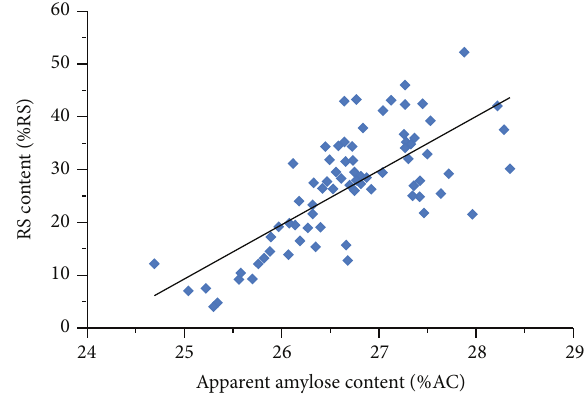
Figure 2: Relationship between amylose content and resistant starch contents in